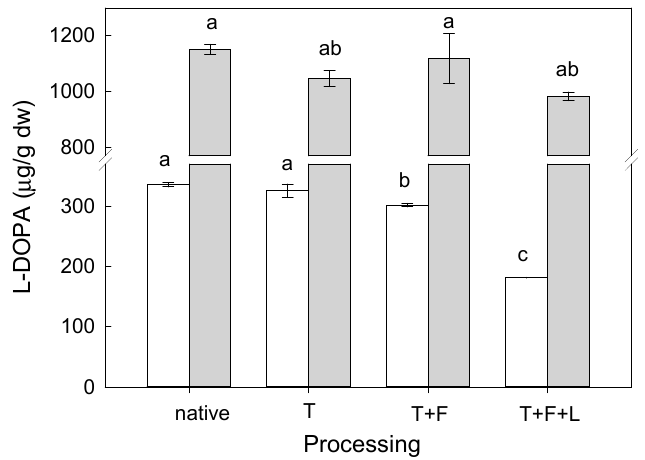
Figure 5. l -DOPA concentration found in V. faba var. major Bolero (white bars) and in V. faba var. minor Fernando (grey bars) after heating (T), freezing (F), lyophilisation (L); extraction was performed in the best conditions determined before. The same letter next to the l -DOPA contents indicates no statistical di ff erence according to the Tukey’s test ( p >